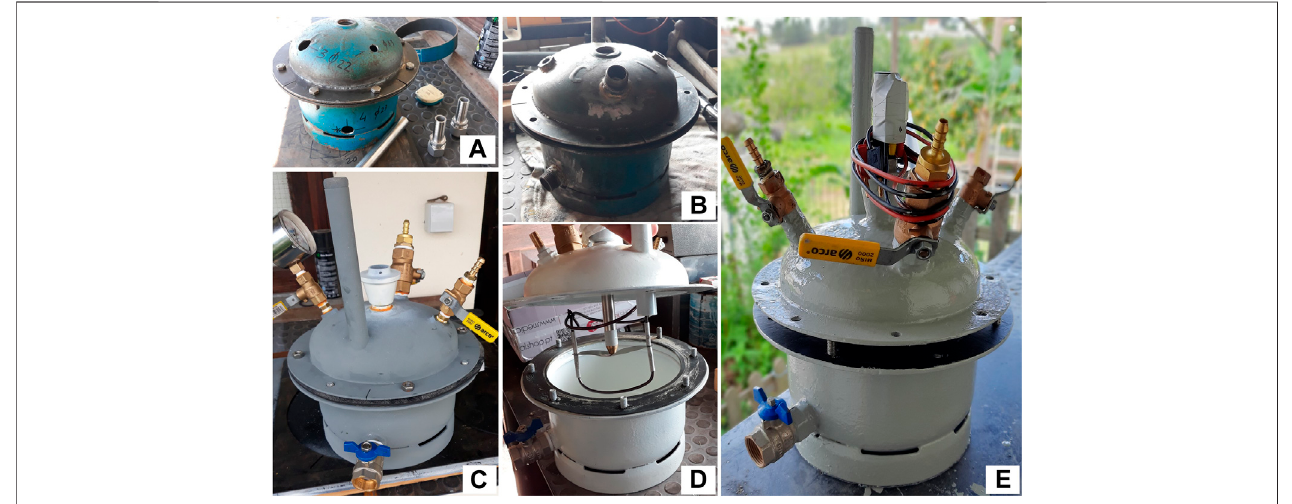
FIGURE2| Constructionphasesoftheanaerobicdigester. (A) Cutting,drillingand fl angeswelding; (B) Weldingofthreadedparts; (C) Primerapplicationandparts assembly; (D) Painting and assembly of the mechanical stirring system; (E) Final assembly.